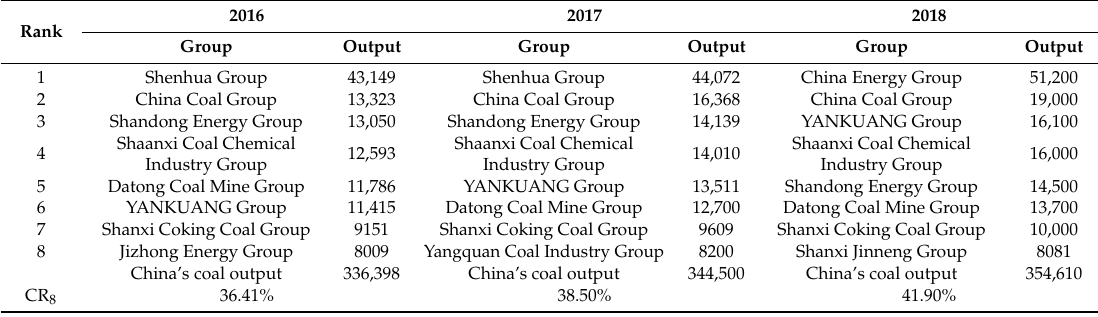
Table 4. Output (TOP8) and CR 8 in China’s coal industry (unit: 10,000